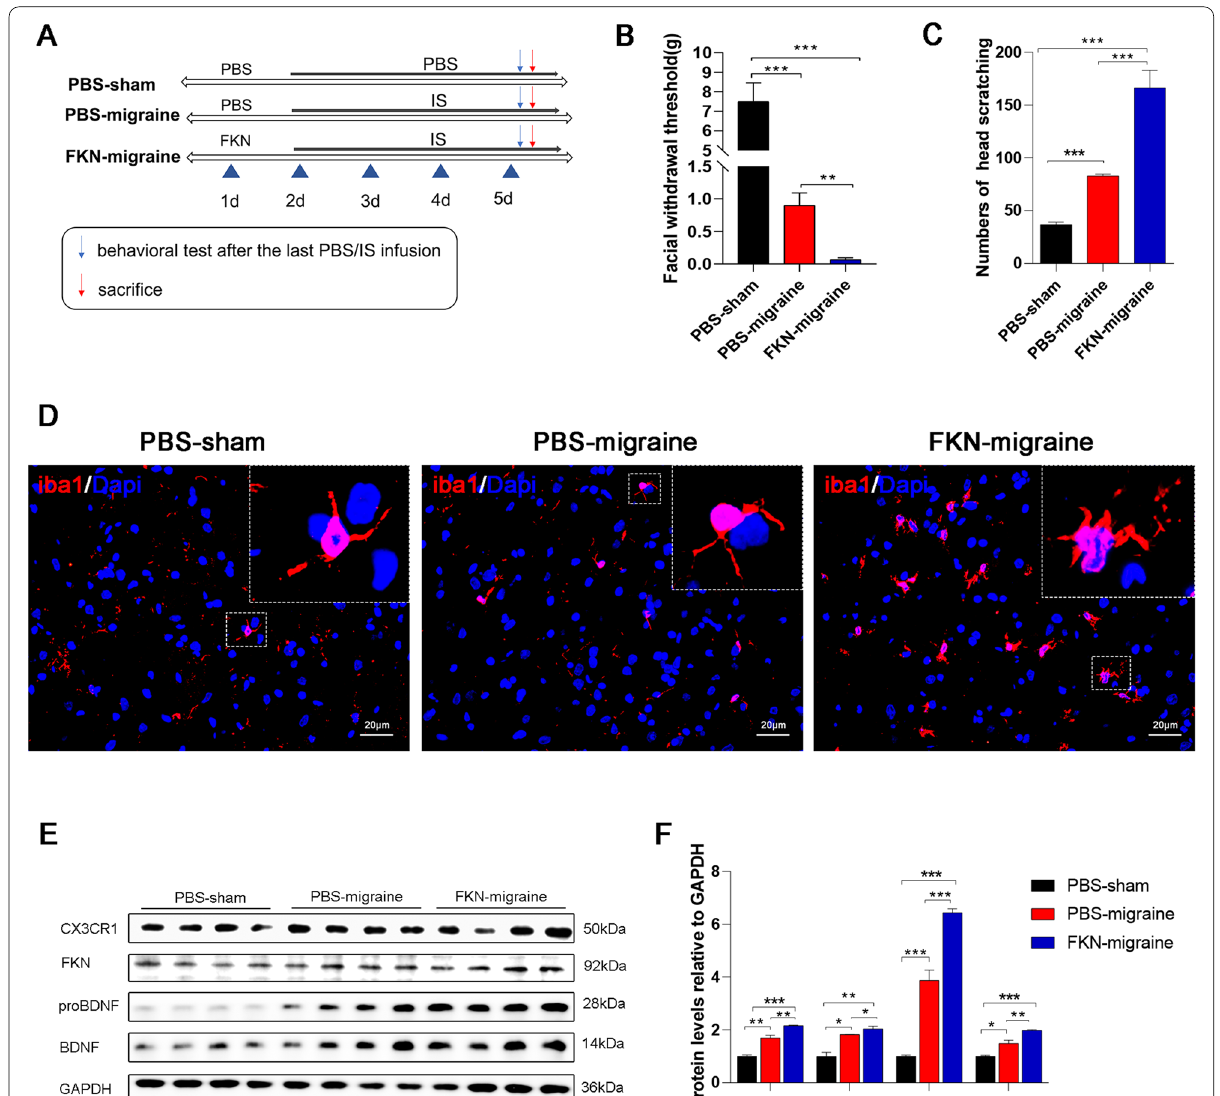
Fig. 6 FKN infusion exacerbated the SE-induced increase in nociceptive behaviour, microglial activation, and relative protein upregulation. A Flow chart showing PBS-sham, PBS-migraine, and FKN-migraine experimental groups. B The mechanical threshold in the PBS-migraine group was decreased compared to that in the PBS-sham group and further decreased in the FKN-migraine group. Mean SEM; one-way ANOVA; n 6 rats per ± = group; ** P < 0.01, *** P < 0.001. C Head-scratching counts were increased in the PBS-migraine group, compared to the PBS-sham group and were further increased after FKN infusion. Mean SEM; one-way ANOVA; n 6 rats per group; ** P < 0.01, *** P < 0.001. D Immunofluorescence staining of ± = iba1 shows that FKN exacerbated epileptic microglial activation and increased microglial numbers. Scale bar 20 μm. The white box was enlarged. = E Representative western blot films showing CX3CR1/FKN/proBDNF/BDNF/iba1 protein expression in the sp5c in different groups. F Quantification of CX3CR1/FKN/proBDNF/BDNF/iba1 protein levels in the PBS-sham group, PBS-migraine group, and FKN-migraine group. Mean SEM; one-way ± ANOVA; n 3 rats per group; * P < 0.05, ** P < 0.01, *** P < =